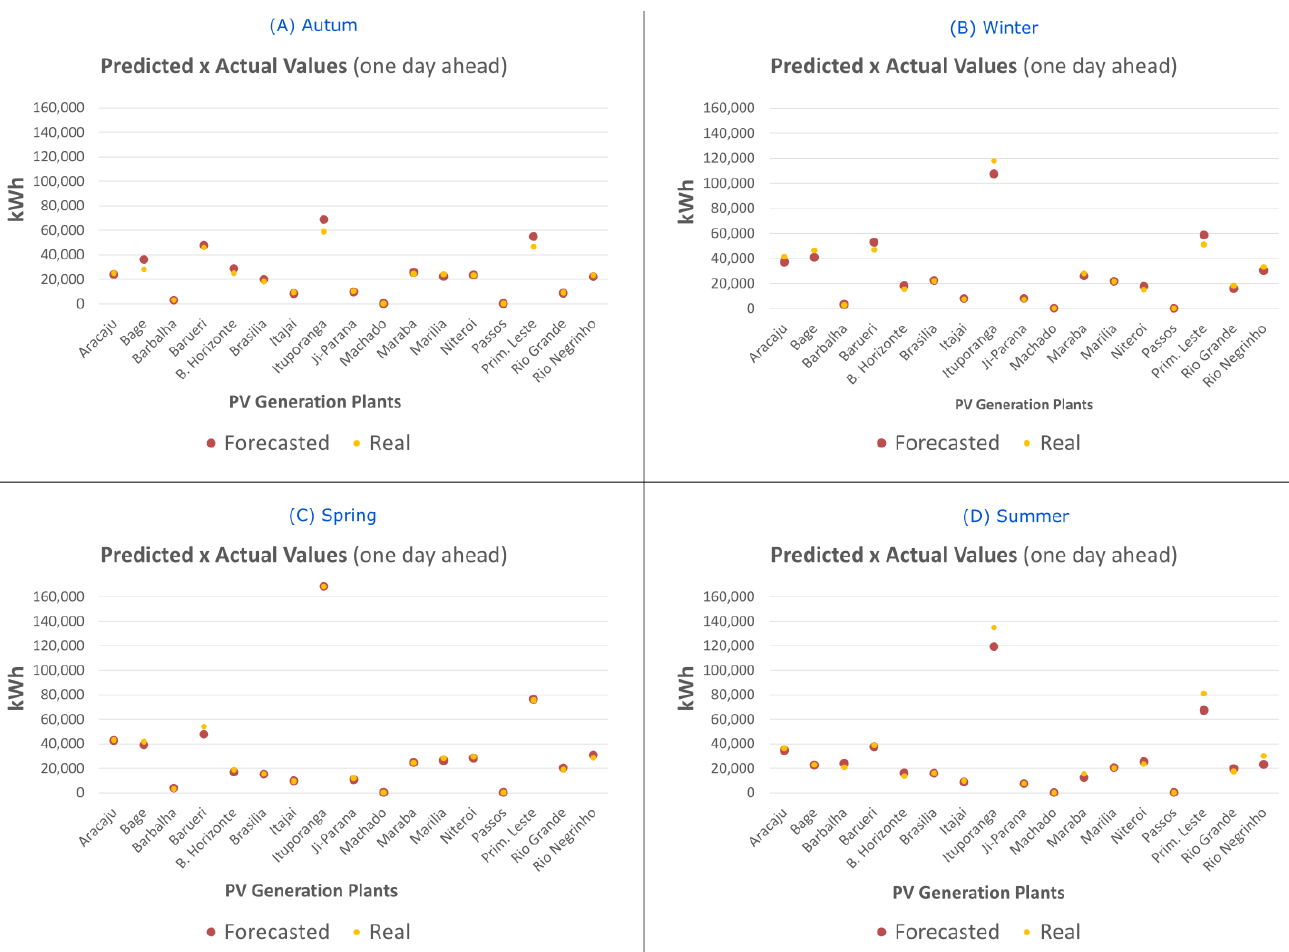
Figure 15. Predicted versus actual values plot, grouped by season.